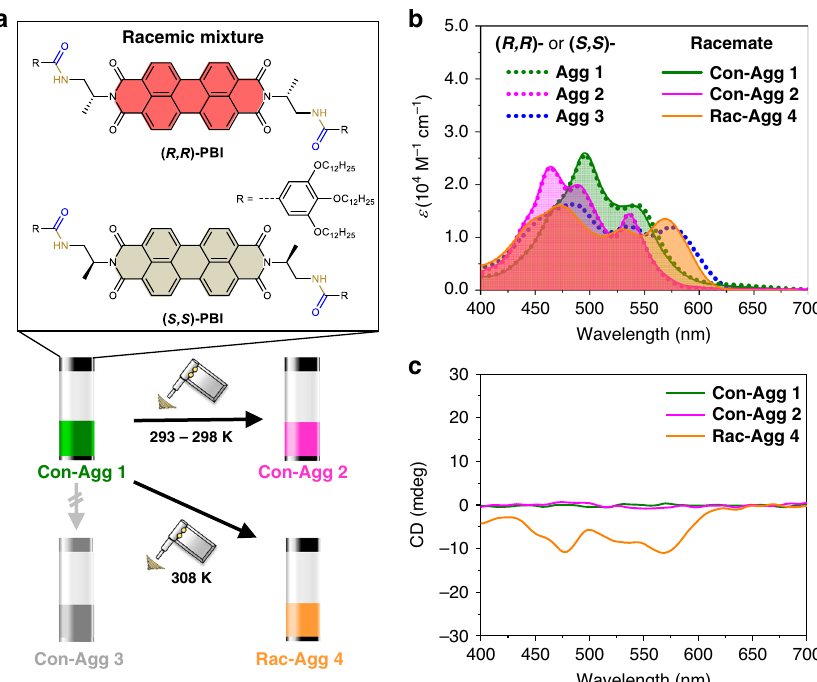
Fig. 1 Spectroscopic studies of the racemic mixture of (R,R)- and (S,S)-PBI. a Chemical structures of ( R,R )- and ( S,S )-PBI and schematic depiction of the ultrasound-induced supramolecular polymerization of the racemic mixture of ( R,R )- and ( S,S )-PBI into the conglomerates Con-Agg 1 and Con-Agg 2 and racemic supramolecular polymer Rac-Agg 4 . b UV/vis-absorption and c CD spectra of the three different supramolecular polymorphs of the racemic mixture of ( R,R )- and ( S,S )-PBI (solid lines; c T = 3.0× 10 − 4 M for Con-Agg 1 and Con-Agg 2 ; c T = 4.0× 10 − 4 M for Rac-Agg 4 ; 298K) in MCH/Tol (5:4, v / v ). For comparison, the absorption spectra of ( R,R )-Agg 1 – 3 (dotted lines) have been included in b . We note that the observed CD spectrum of Rac-Agg 4 is an LD artefact 52 (further discussed in Supplementary